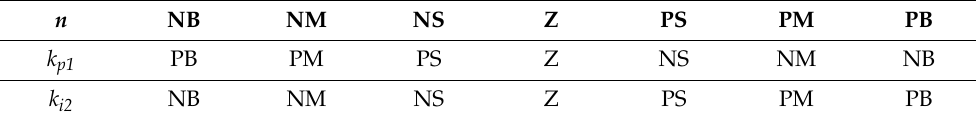
Table 4. Fuzzy rules for k p 2 and k i 2